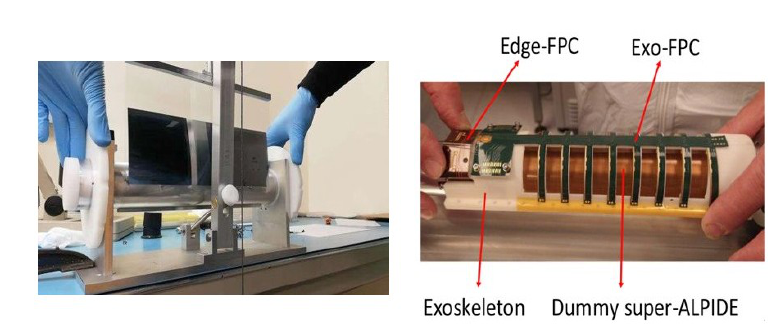
Fig. 6. Mechanical tool developed for bending the super-ALPIDE (left) and main components designed for the electrical assembly (right).